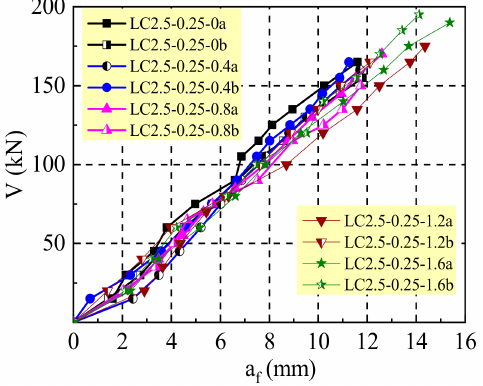
Figure 4. Mid-span deflection of test